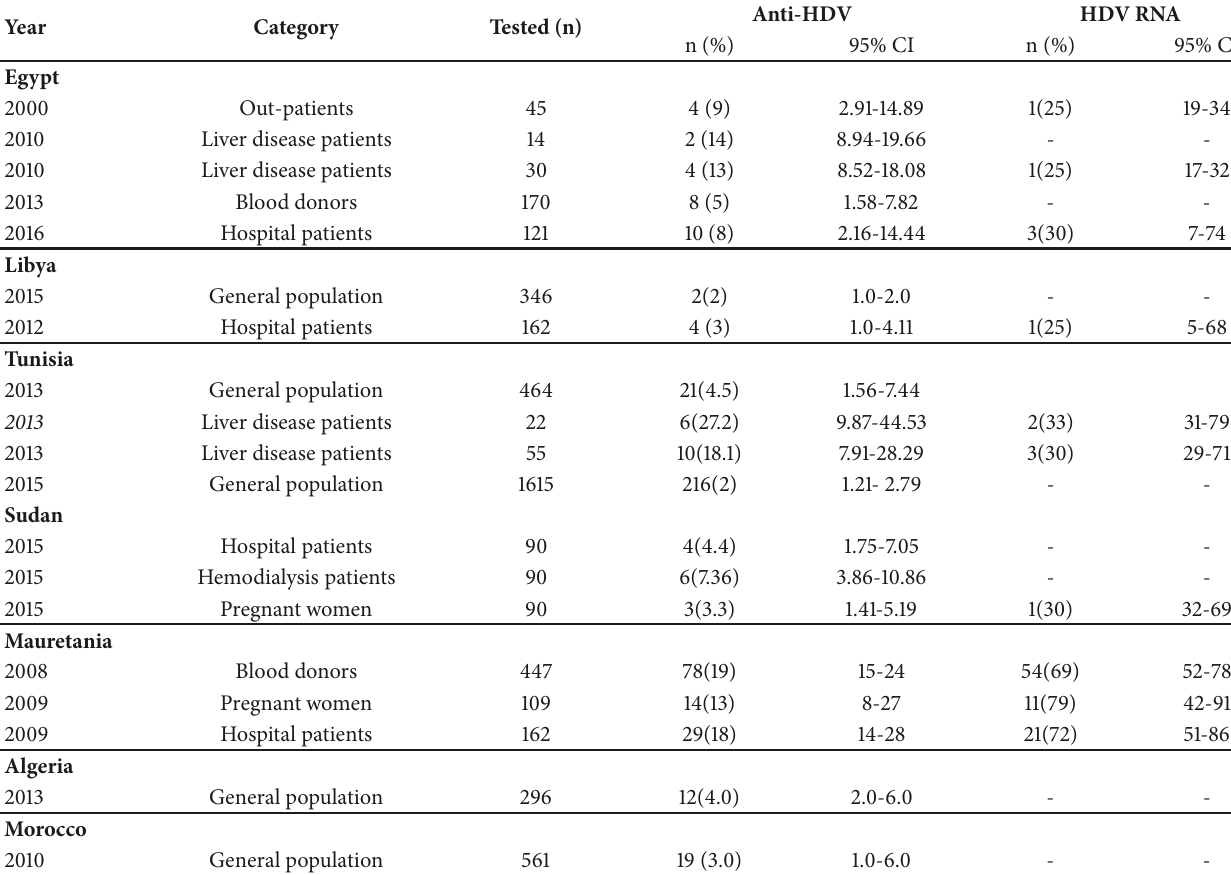
Table 1: Prevalence of antihepatitis D virus and hepatitis D virus RNA in HBsAg-positive populations in North Africa. Yea